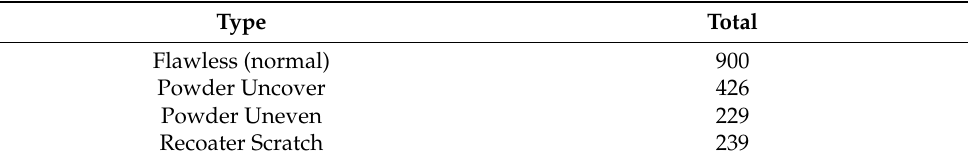
Table 2. Statistics of all data.